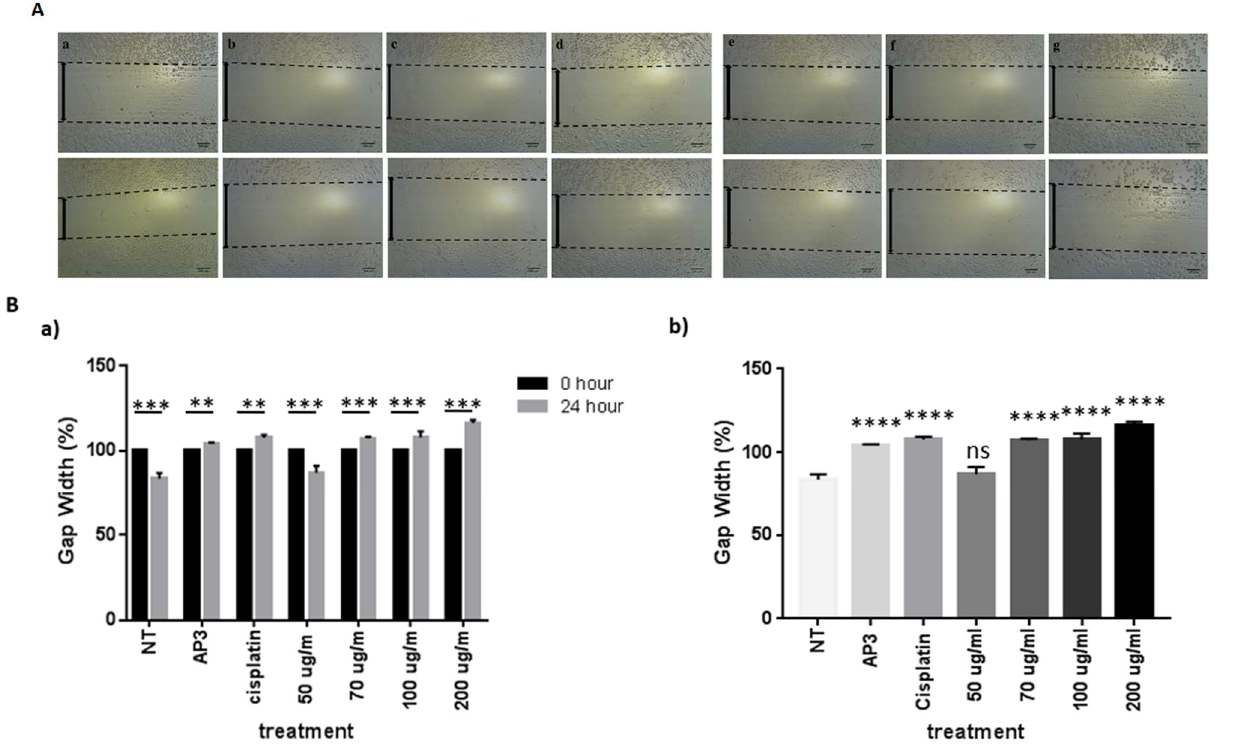
Figure 2. ( A ) Photomicroscopic images of A549 cells during the scratch wound healing assay. The cells were cultivated under normal conditions as non-treated cells ( a ), in the presence of an inhibitor (AP3) as the positive control ( b ), with cisplatin as the commercial drug comparison ( c ), and with EEOS at concentrations of 50 ( d ), 70 ( e ), 100 ( f ), and 200 g/mL ( e ). The wound healing was observed at the 0th hour and after 24 h. ( B ) Ethanolic extract of Ocimum sanctum Linn. reduced the migration ability of non-small cell lung carcinoma (A549), as shown by the scratch wound assay. The cells were cultivated in the presence of an inhibitor (AP3) as the positive control, cisplatin as the commercial drug comparison, and EEOS at concentrations of 50, 70, 100, and 200 g/mL. ( a ). The wound healing was observed at 0 h and after 24 h. ( b ). The wound healing after 24 h. Statistical analysis was performed via one-way ANOVA, followed by post hoc Tukey test (NT: non-treated; ** significant p < 0.0060; *** significant p < 0.0009; **** significant p < 0.0001).